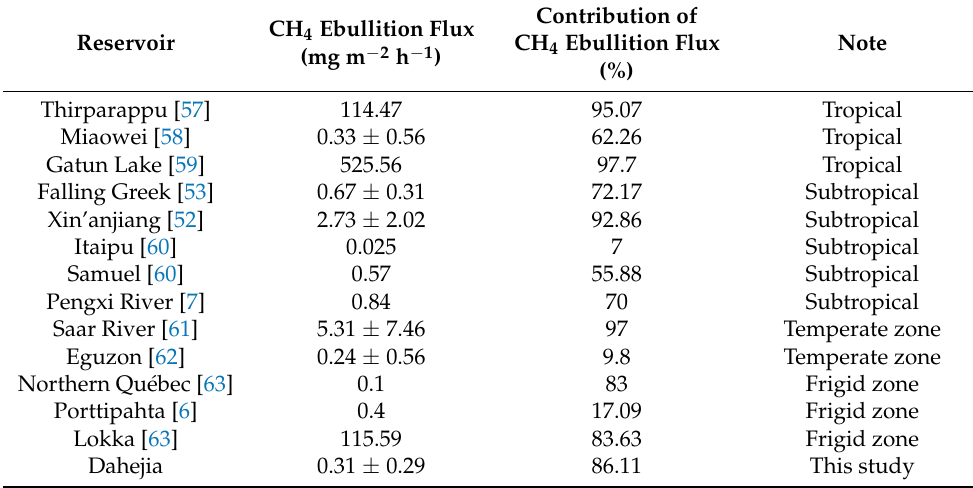
Table 3. CH 4 ebullition flux from global